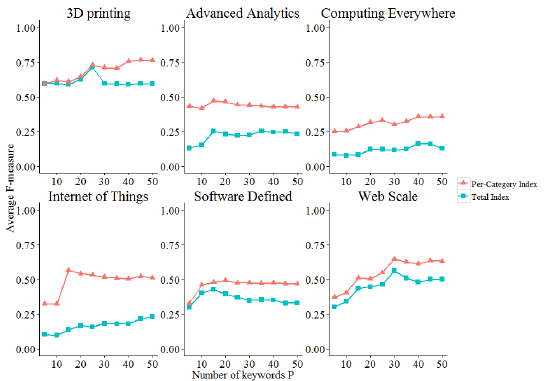
Fig. 10. Indexing Structure Evaluation In LDA - Average F- measure in each category across the number of keywords (P) (red line: Per-Category Index, blue line: Total Index)